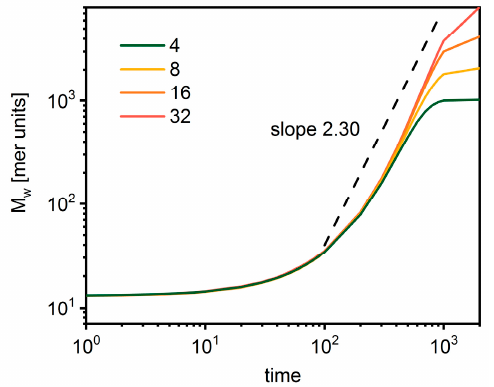
Figure 4. The average total mass of the dendrimer as a function of time. The color indicates the number of macromolecules in the system (see text for details).